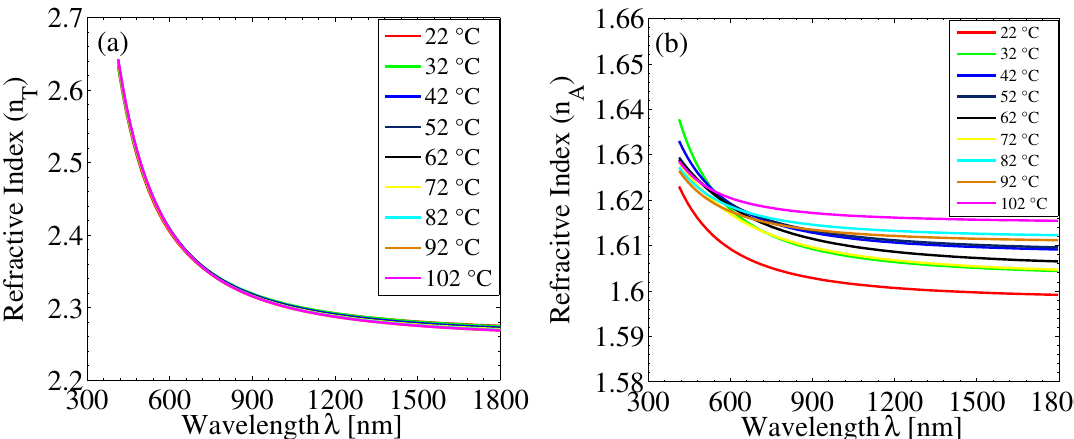
Figure 4. Dispersion relation of refractive indices of ( a ) a 100 nm-thick ALD-TiO ( b ) a 30 nm-thick ALD-Al